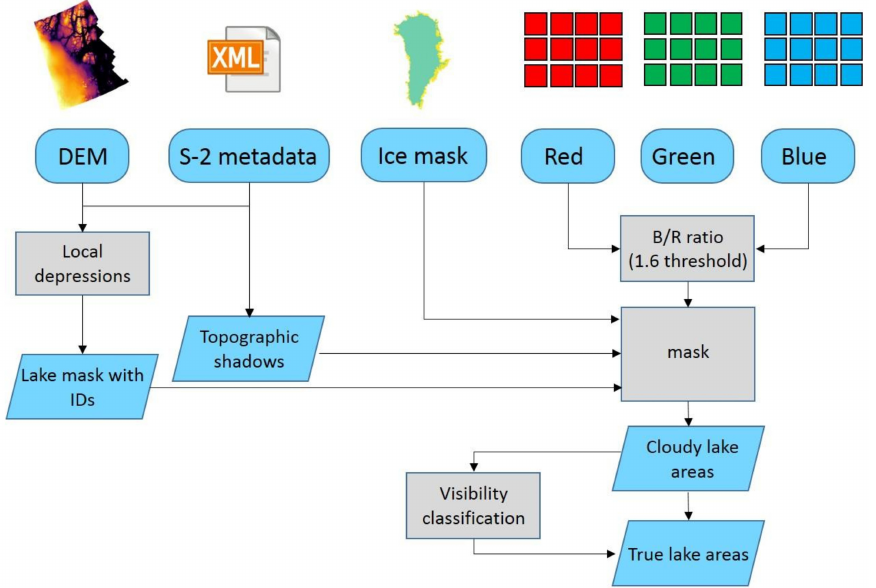
Figure 2. Flowchart of the data and methods applied. Rounded rectangles are input data; gray rectangles are processes, and blue parallelograms (intermediate)